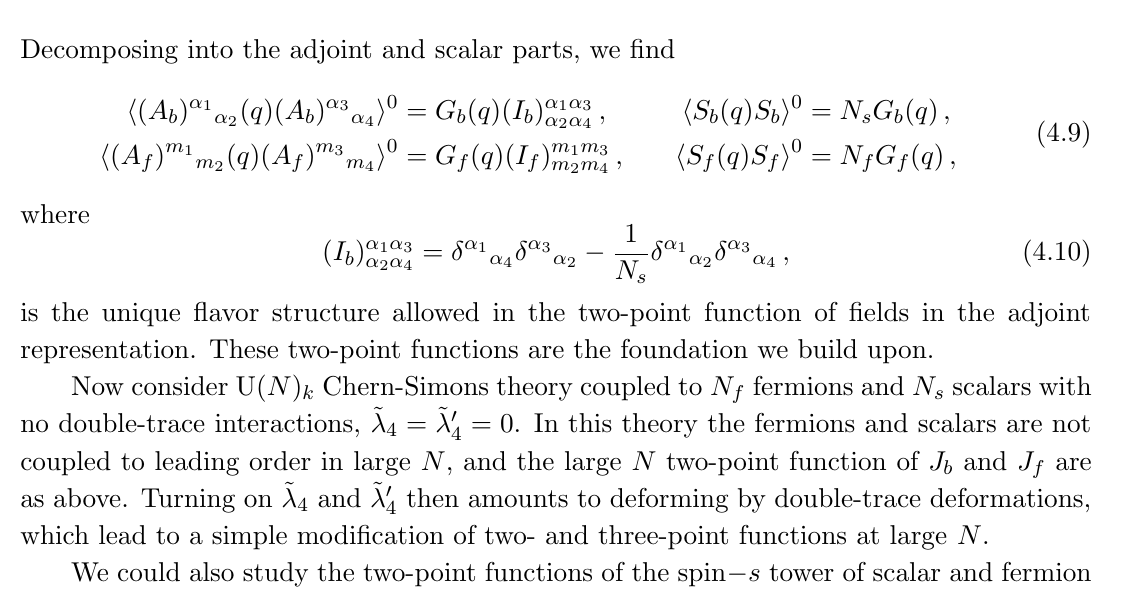
Figure 2 . The two-point function of J b in the double-trace deformed theory is a sum of bubbles involving the two-point function of J b in the undeformed theory and that of J f , denoted by